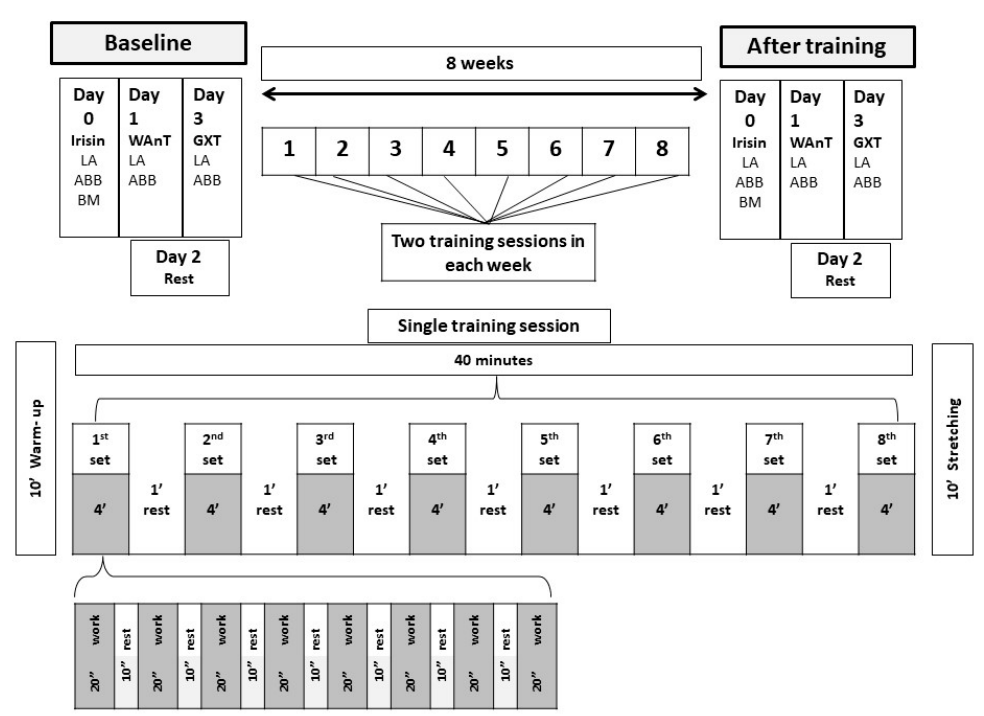
Figure 1. Scheme of the training sessions. LA = Lactate, ABB = Acid–Base Balance, BM = Body mass.